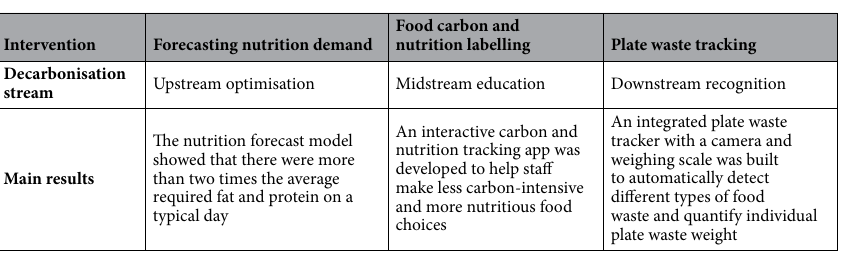
Table 3. Summary of the main results for each of the three interventions investigated in the case study.